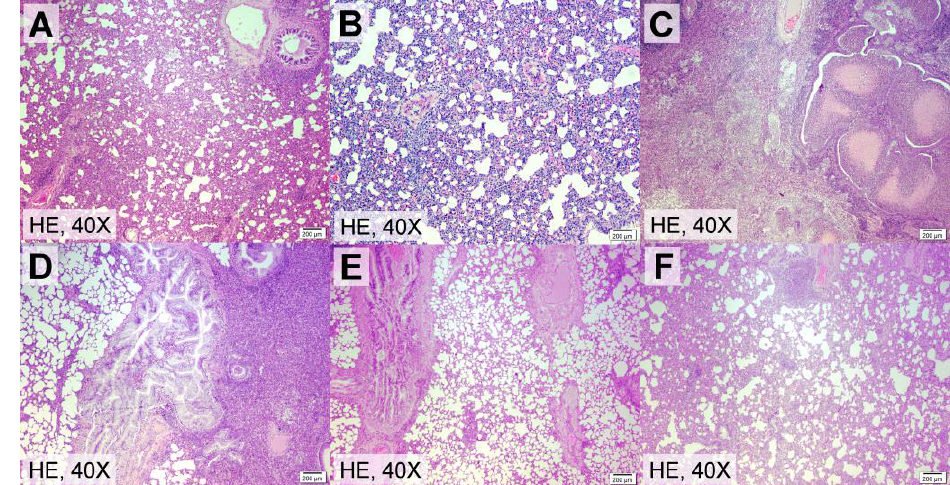
Figure 3. Histopathological lesion found in lung with HE routine staining with magnification of 40x. Groups without gel treatment showed more areas of alveoli filled with inflammation infiltrate. Among the cigarette smoke (A), coal smoke (B), and mosquito coil smoke group (C), the most wide spread lesion area was found in the latest group, as well as necrotic area and bronkhiolus metaplasia. Compared to the untreated groups, the groups with gel treatment showed better histopathologically features. Alveoli filled inflammation infiltrate area was far lesser in the cigarette smoke with gel (D), coal smoke with gel (E), and mosquito coil smoke with gel group (F). Although, the lesion in mosquito coil smoke with gel group still showed the worst histopathological lesion such as necrosis and bronkhiolus metaplasia between the three treated groups.